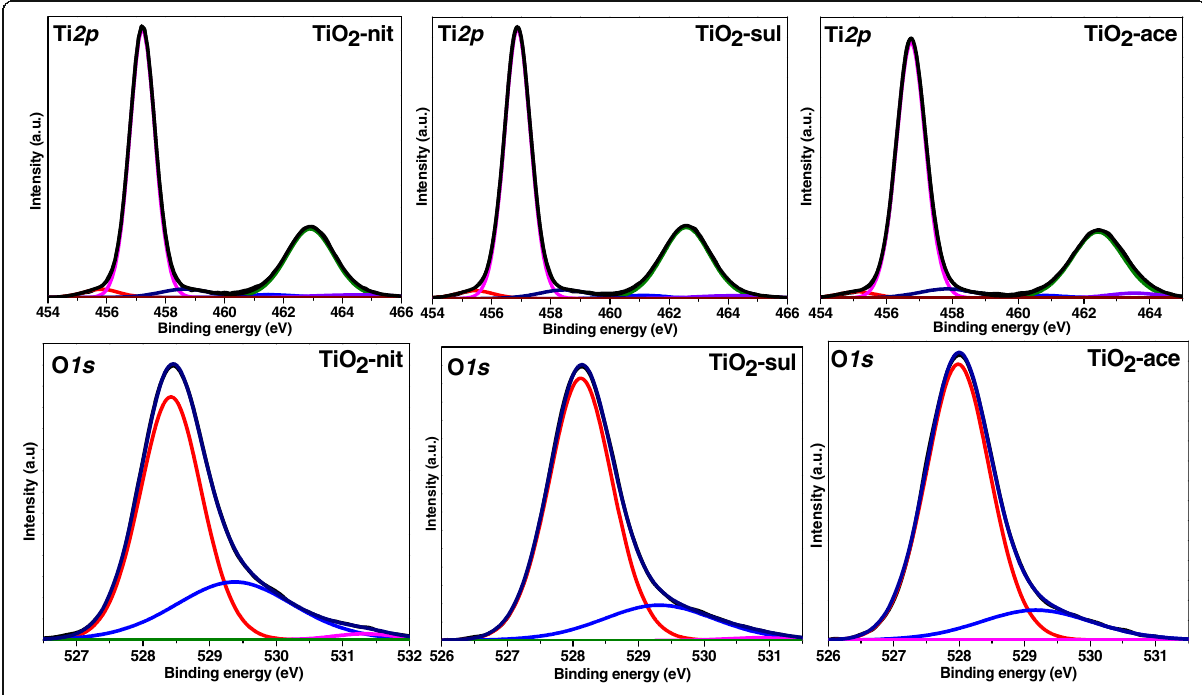
Fig. 7 Ti 2p and O 1s X-ray photoelectron spectra for the calcined TiO 2 samples